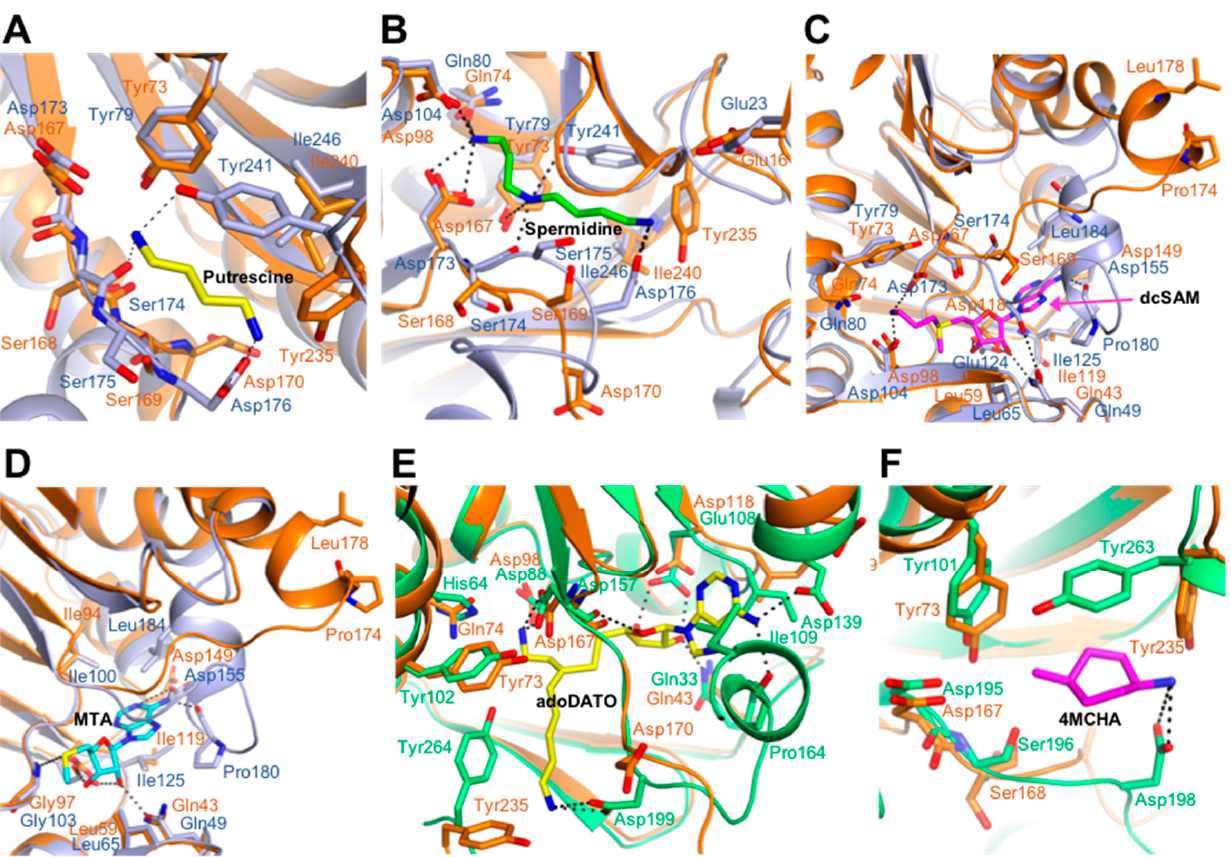
Figure 4. Superposition of the Kl SpdS structure with SpdS-ligand complexes. ( A ) Superposition of the structures of spermidine synthase (SpdS) from Kluyveromyces lactis ( Kl SpdS) and the Homo sapiens ( Hs SpdS)–putrescine complex. The substrate putrescine is shown in yellow. The panel provides a detailed view of the interaction between putrescine and Kl SpdS, with overlaid Hs SpdS. Kl SpdS and Hs SpdS residues are shown in orange and light blue, respectively. ( B ) Superposition of the structures of Kl SpdS and the Hs SpdS–spermidine complex. The product spermidine is shown in green. The panel provides a detailed view of the interaction between spermidine and Kl SpdS, with overlaid Hs SpdS. Kl SpdS and Hs SpdS residues are shown in orange and light blue, respectively. ( C ) Superposition of Kl SpdS and the Hs SpdS–dcSAM complex structures. The cofactor dcSAM is shown in magenta. The panel provides a detailed view of the interaction between dcSAM and Kl SpdS, with overlaid Hs SpdS. Kl SpdS and Hs SpdS residues are shown in orange and light blue, respectively. Abbreviations: dcSAM, decarboxylated S -adenosylmethionine. ( D ) Superposition of Kl SpdS and the